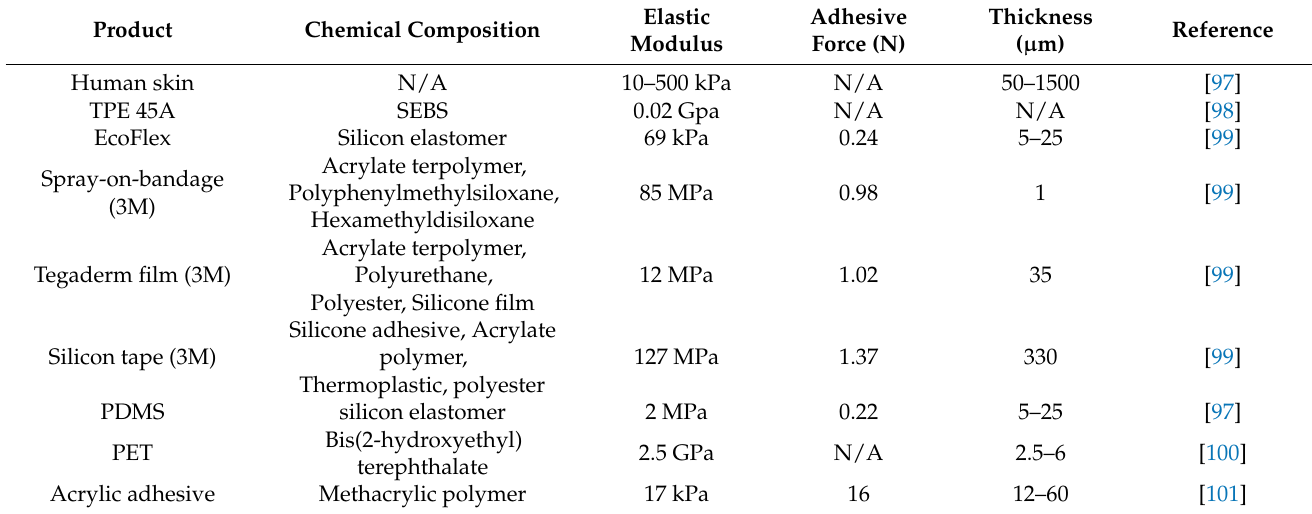
Table 2. Mechanical properties of existing substrates used for wearable sensors and bandages in comparison to human